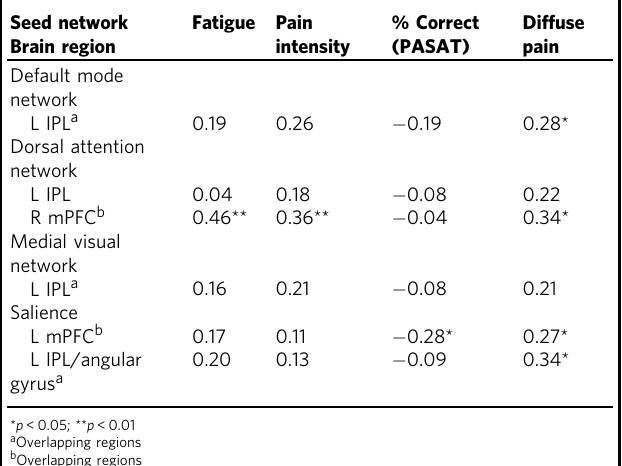
Table 5 Pearson correlations between functional connections and clinical symptoms Seed network Brain